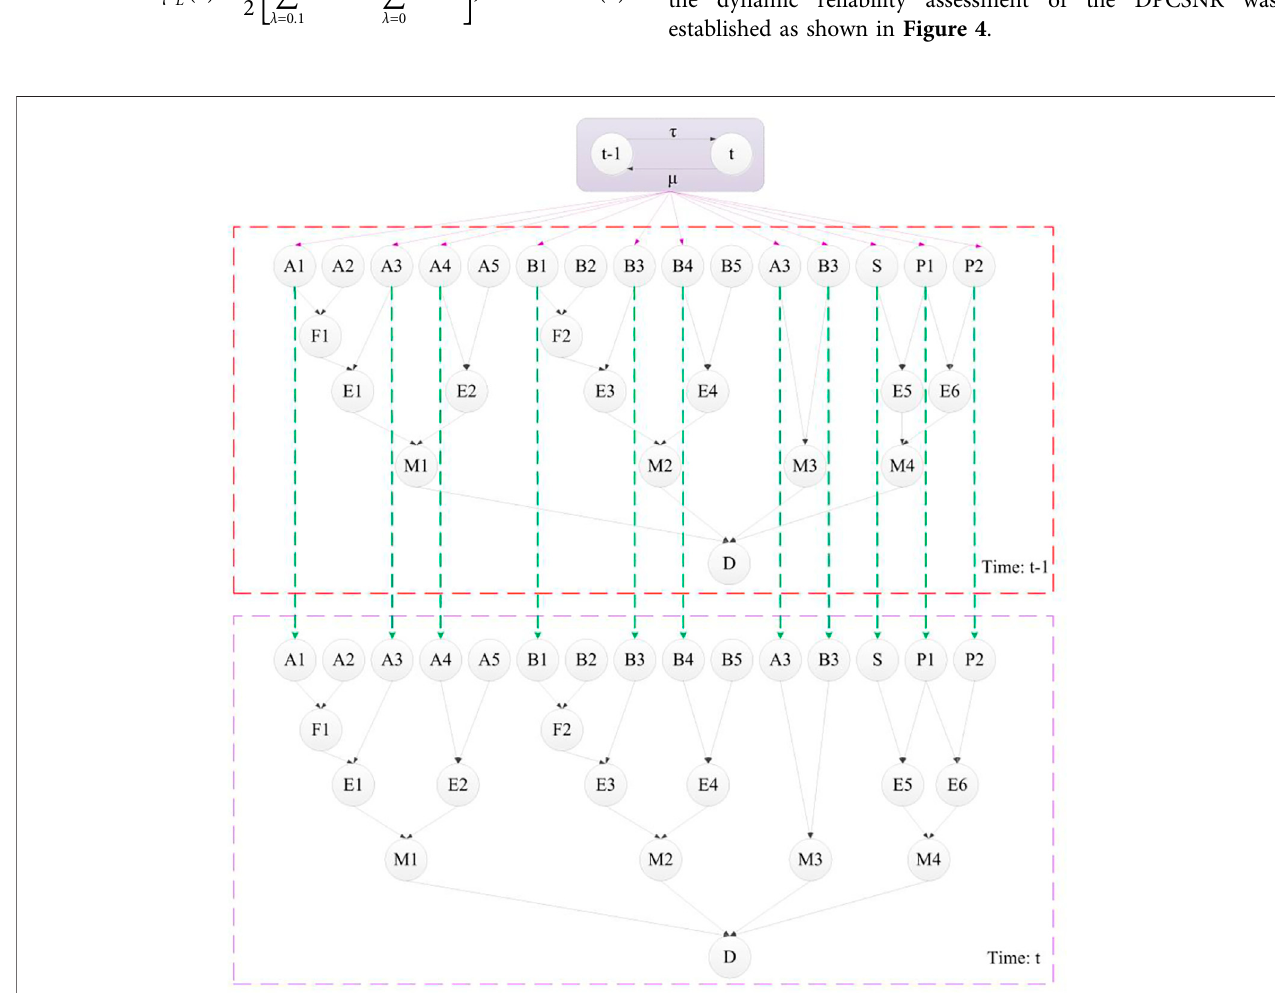
FIGURE 4 | DBN model for the dynamic reliability assessment of the